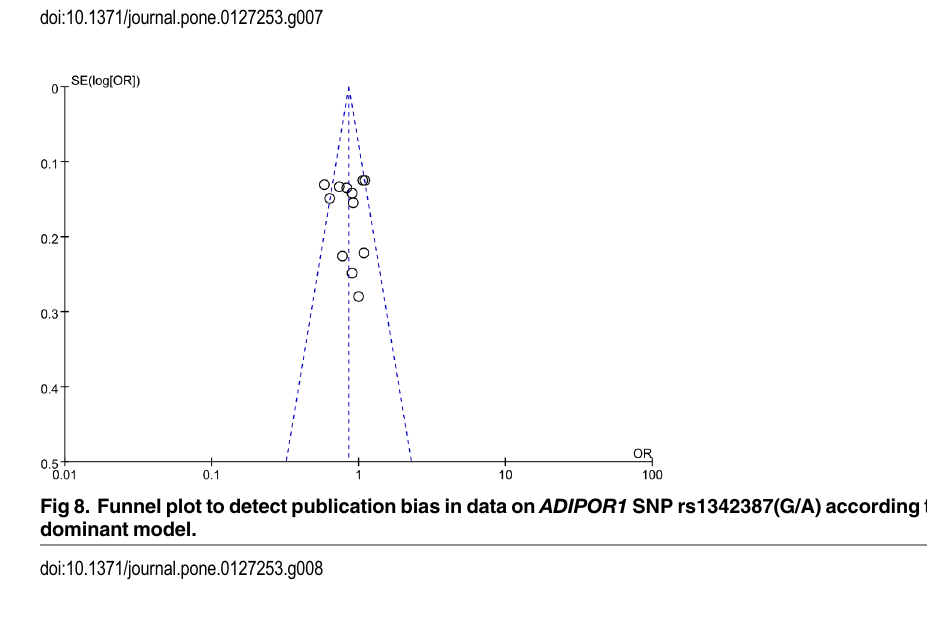
Fig 7. Funnel plot to detect publication bias in data on ADIPOR1 SNP rs12733285(C/T) according to a dominant model.